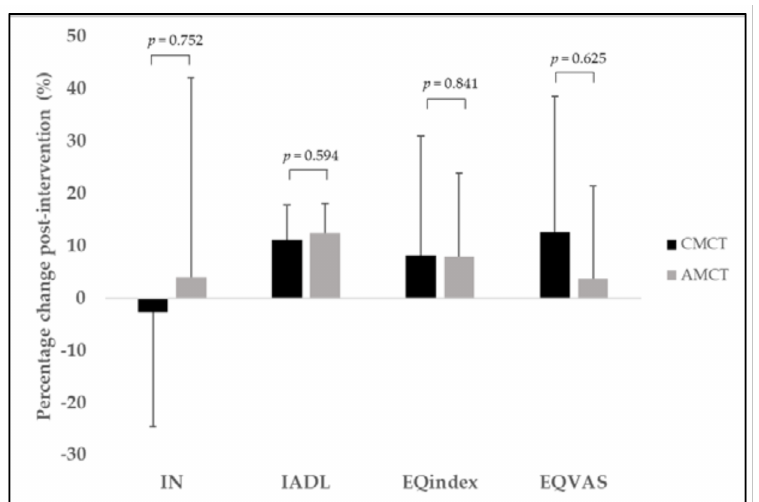
Figure 3. Percentage change in executive function, Instrumental Activities of Daily Living, and health-related quality of life measurements following CMCT (solid bar) and AMCT (gray bar). IN, inhibition; IADL, Instrumental Activities of Daily Living; CMCT, continuous multicomponent training; AMCT, accumulated multicomponent training. For all variables, the greater the percentage change, the greater the